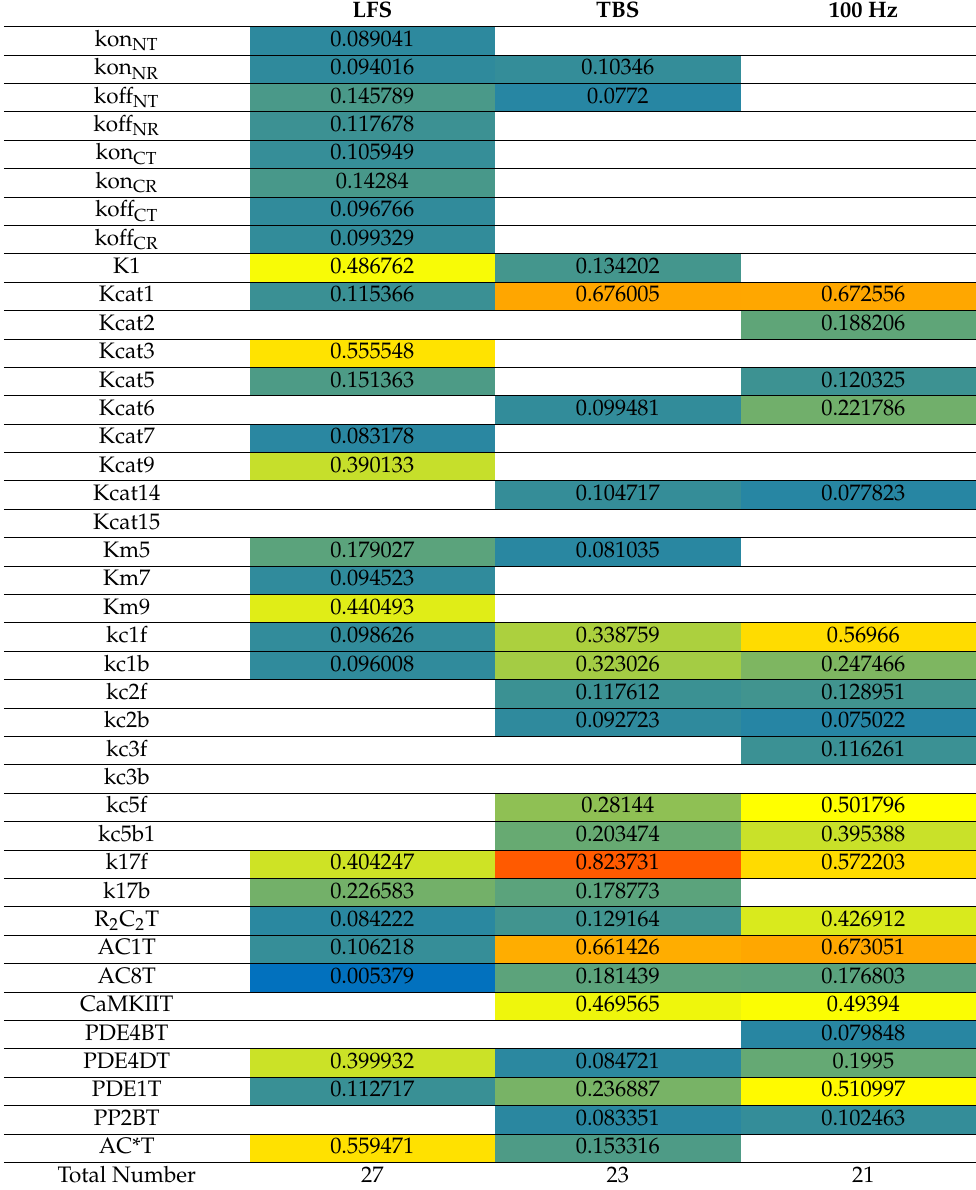
Table 5. GSA of cAMP. Each row represents a model parameter and its PRCC at each of the three stimulations. Empty cells represent no significant PRCC value ( p < 0.0001). The color indicates the significance of PRCC values: Blue is low significance; Green is moderate significance; Yellow is high significance; and Red means very strong